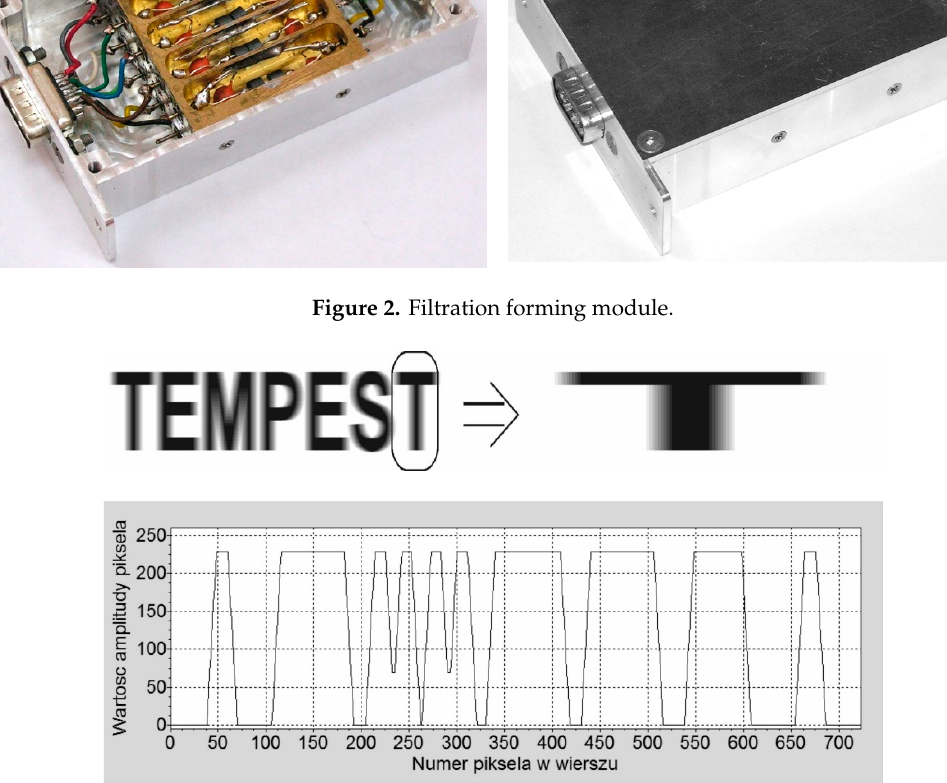
Figure 2. Filtration forming module.